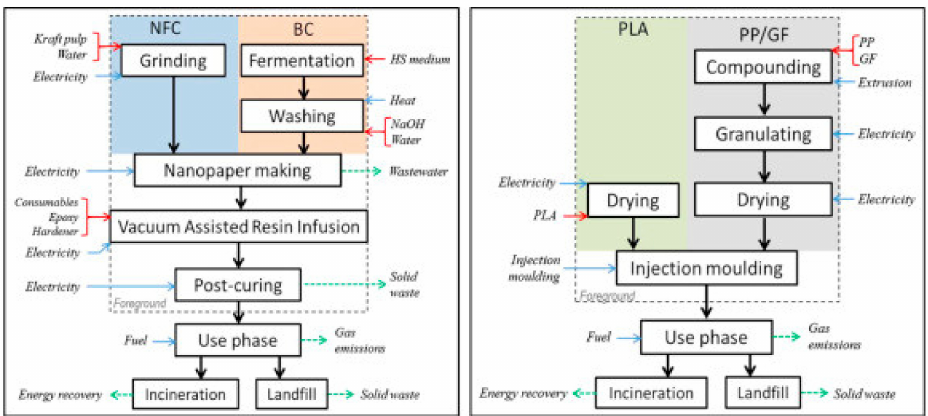
Figure 27. Schematic diagram showing the system boundaries of the model representing the life cycle of bacterial cellulose (BC-) and nanofibrillated cellulose (NFC)-reinforced polymer composites ( left ), and PLA and glass-fibre / polypropylene (GF / PP) composite ( right ). The red, blue and green arrows represent consumables or raw materials required, energy input and waste (materials and energy), respectively. Reprinted from [102], © 2020 with permission from